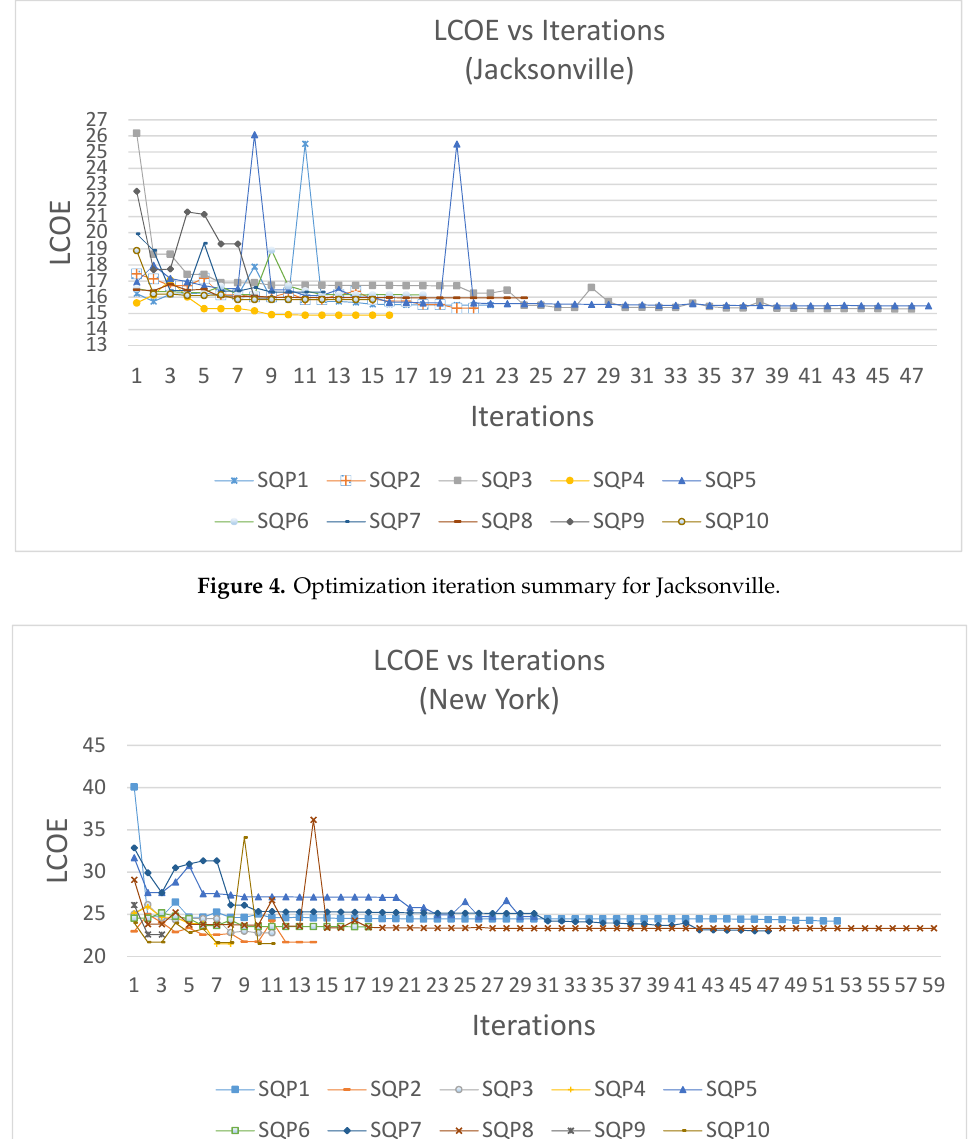
Figure 3. Optimization iteration summary for San Diego. 393